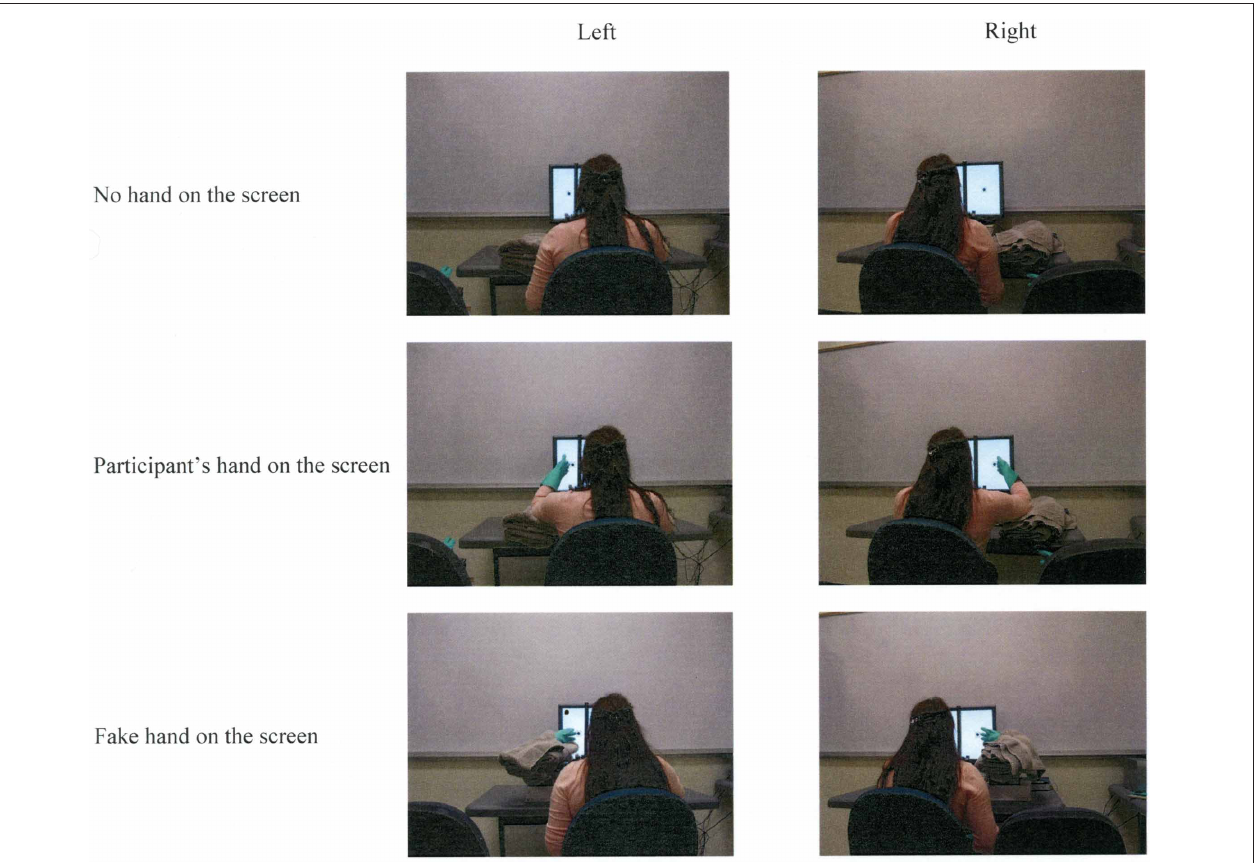
FIGURE 5 | Experimental setup and hand positions in Experiment